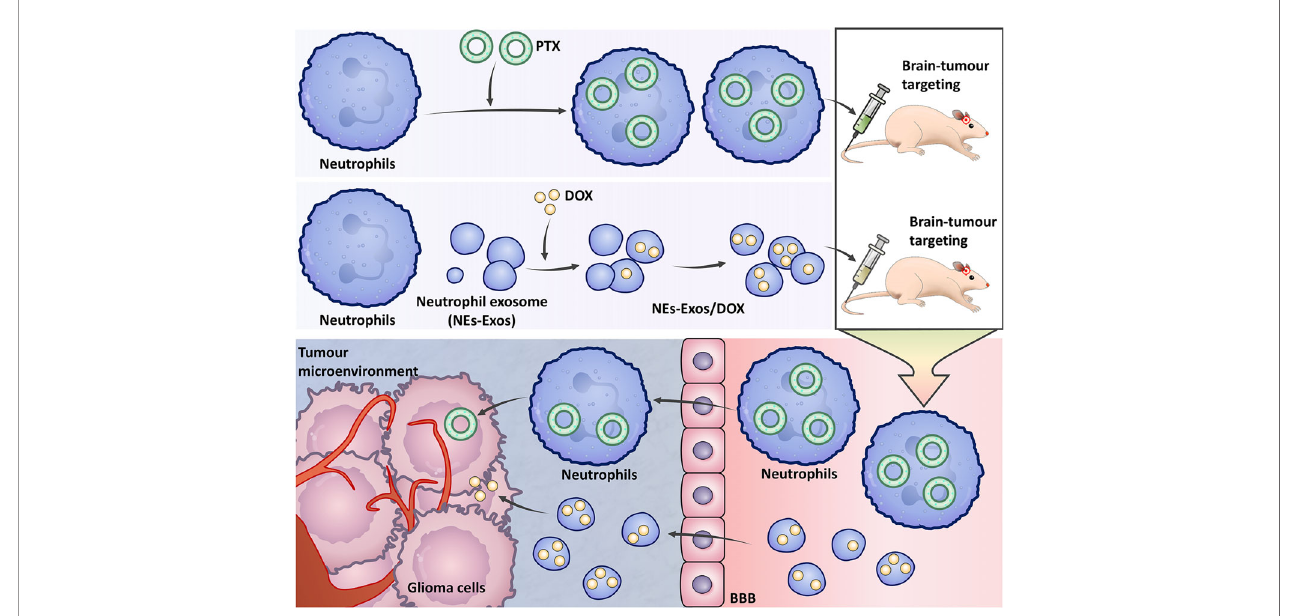
FIGURE 3 | The strategy uses neutrophils to treat gliomas. Neutrophils carry paclitaxel (PTX) liposomes to treat gliomas. In the neutrophil-derived exosome (NEs- Exos) drug delivery system, the anticancer drug doxorubicin (DOX) is loaded into the nanocarrier for the treatment of